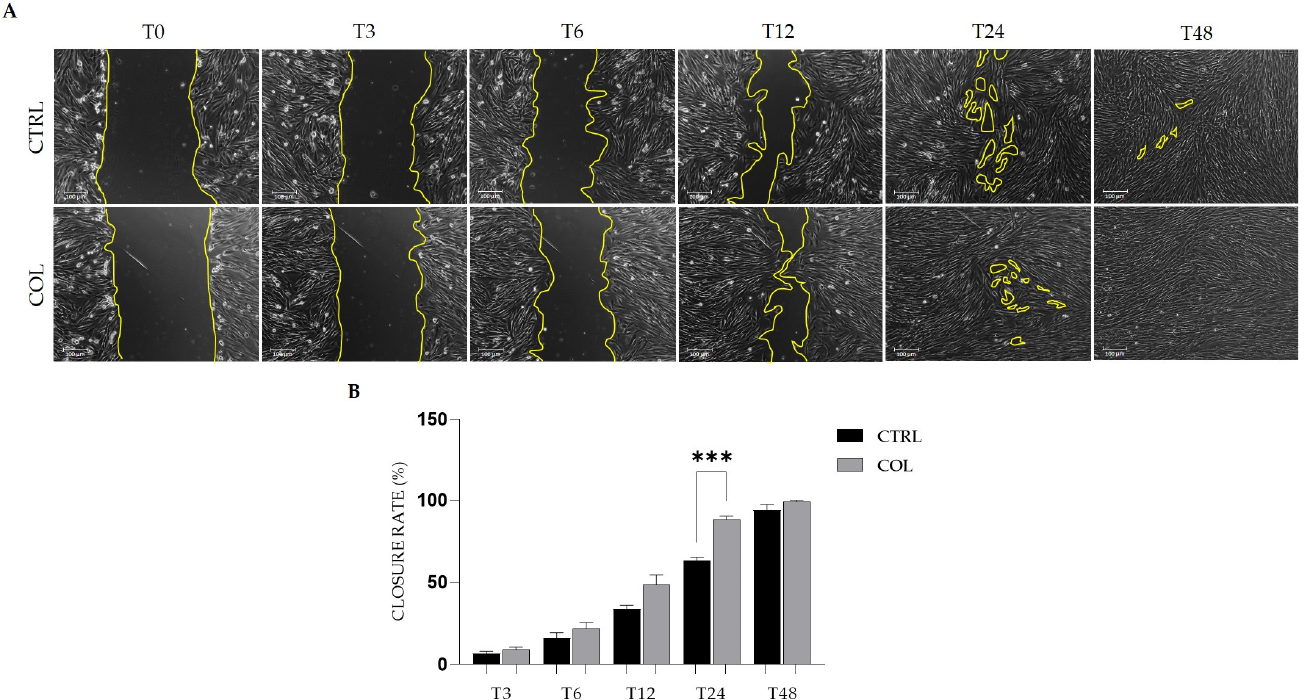
Figure 5. ( A ) Representative phase-contrast micrographs of hGF migration property on uncoated (CTRL) and collagen-coated (COL) cell culture plastic substrates from the time of the scratch (T0) to 48 h (T48). Images were taken by PAULA Smart Cell Imager. Scale bar: 100 µ m. ( B ) Histograms representing the percentage of closure rate in the different experimental conditions. Results are expressed as mean ± standard error (n ≥ 3). Data were obtained by analyzing at least three different fields for each image with ImageJ software. (*** p <